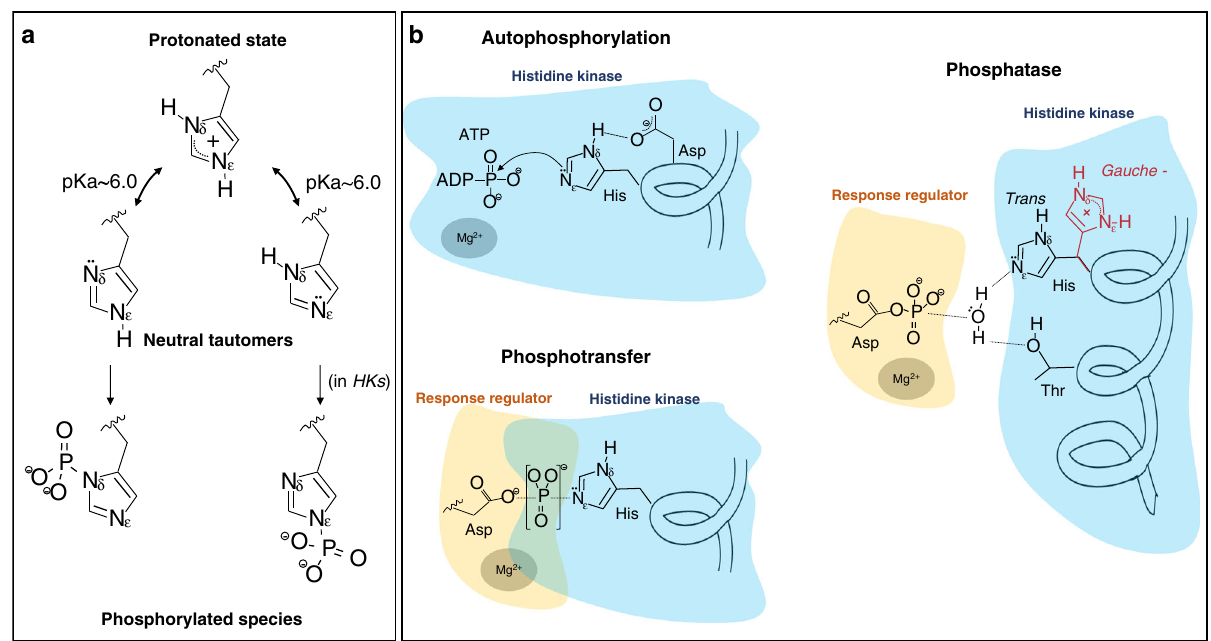
Fig. 1 Chemical versatility of the His side-chain and its role in HKs activities. a Schematic representation of protonation and tautomerization states as well as phosphorylated species of His. Structural and functional studies on HKs support autophosphorylation at N ε 7,8,50 while autophosphorylation at N σ happens at other enzymes such as nucleoside diphosphate kinases 51 . b Schematic representation of the autophosphorylation, phosphotransfer, and phosphatase reaction mechanism of HisKA HKs. In the autophosphorylation, the nucleophilic character of His is enhanced by interactions with an adjacent acidic residue (Asp, herein) to attack γ -P ATP; the phosphotransfer is represented as a transition state between the catalytic residue Asp and His with phosphoryl group; in the phosphatase, a water molecule attacks the catalytic Asp of RRs thanks to its activation by a conserved polar residue (Thr) and the catalytic His. Two distinct rotamers trans and gauche − are shown for the catalytic His, where just the trans rotamer is involved in the